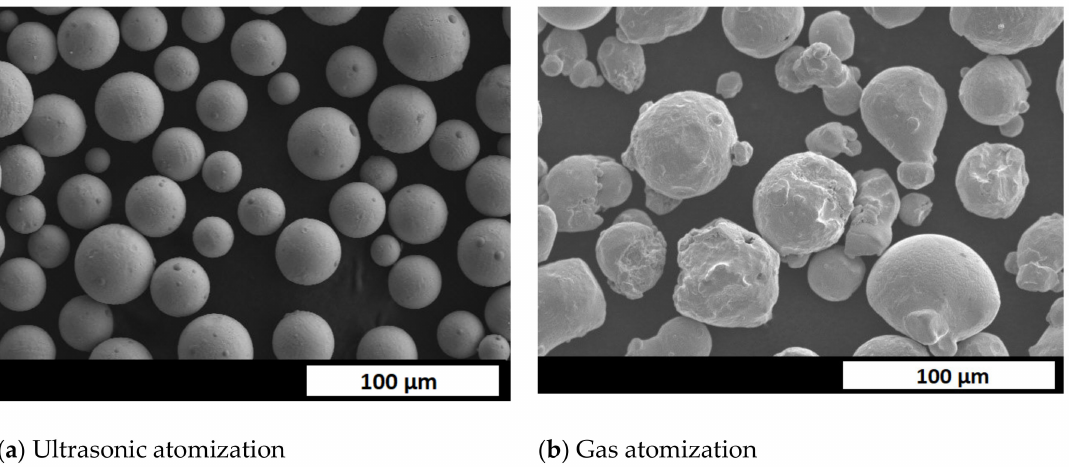
Figure 4. SEM images of <50 µ m ( a ) ultrasonically atomized powder ( b ) gas-atomized